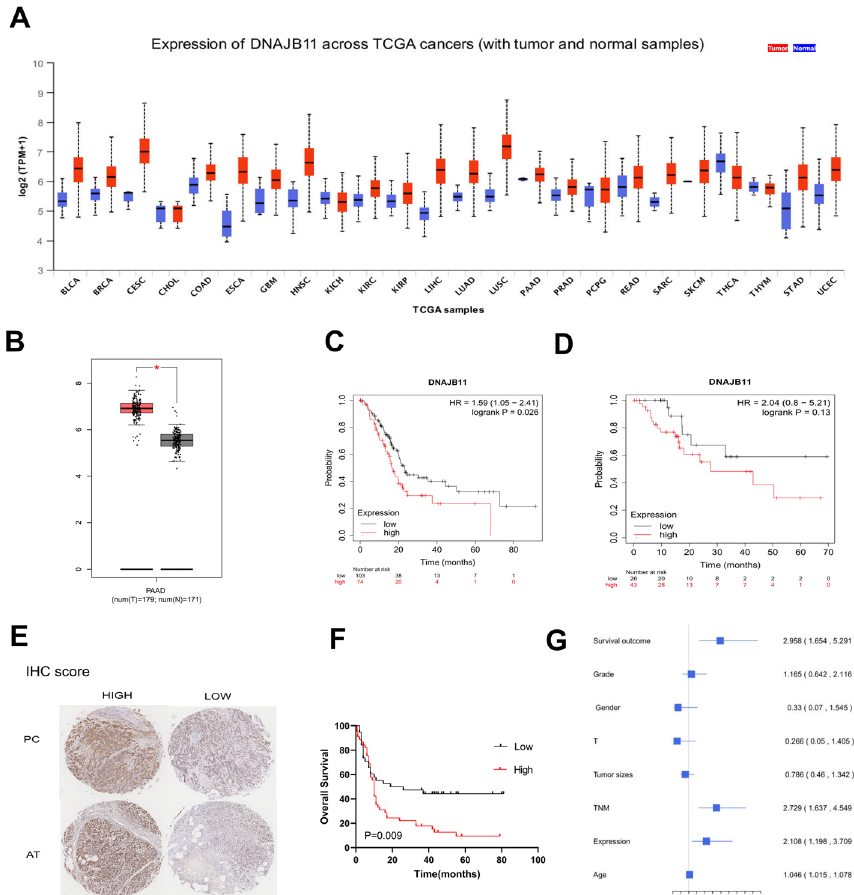
Fig. 2 DNAJB11 expression is elevated in pancreatic cancer tissues and associated with a poor prognosis. A Expression levels of DNAJB11 in most cancers, as shown by the TCGA database. B DNAJB11 exhibits significantly higher expression in pancreatic cancer than in healthy individuals. C Higher DNAJB11 showed a poorer survival rate in patients with pancreatic cancer. D Alterations in DNAJB11 were less correlated with RFS in patients with pancreatic cancer. E Representative images of DNAJB11 staining in tumor tissues and adjacent tissues (AT). Scoring for the IHC is indicated. F Overall survival analysis of patients with pancreatic